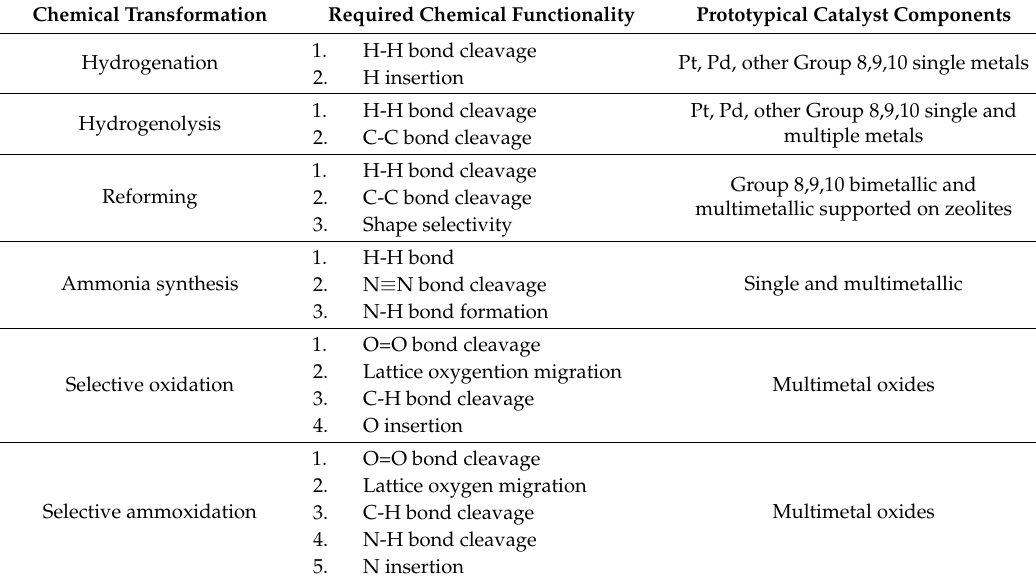
Table 1. Examples of multifunctionality in